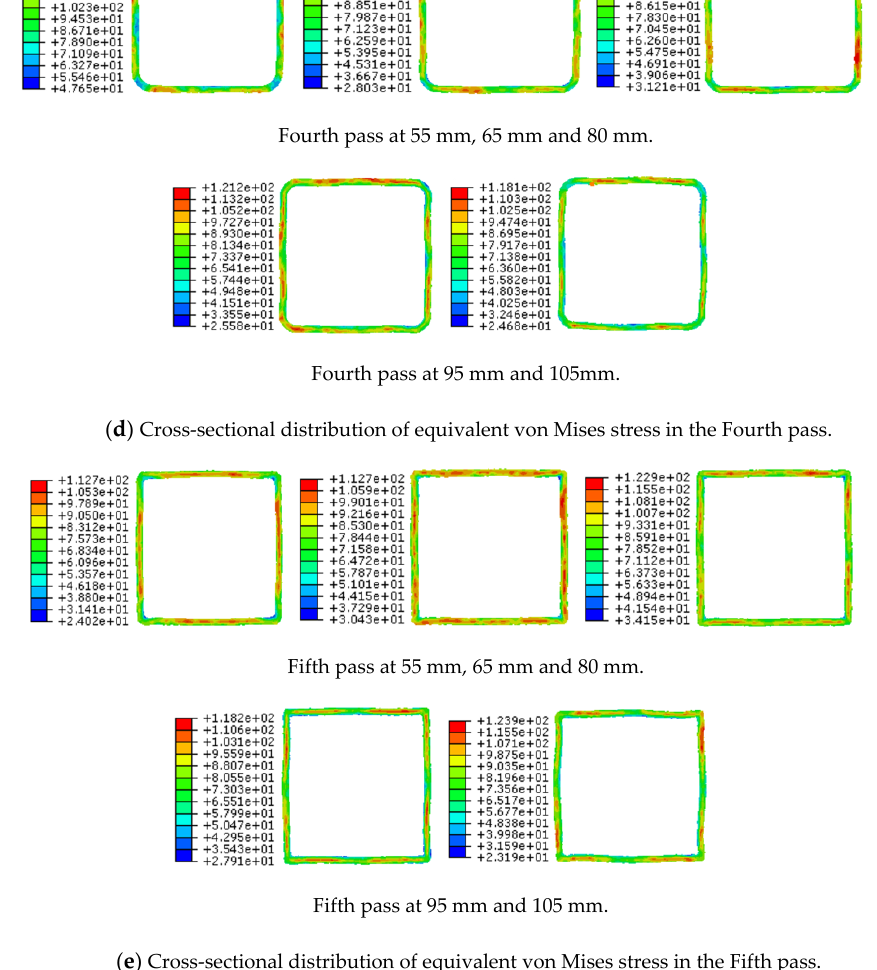
Figure 6. Cross-sectional distribution of equivalent von Mises stress for each pass of the non-circular spinning process.